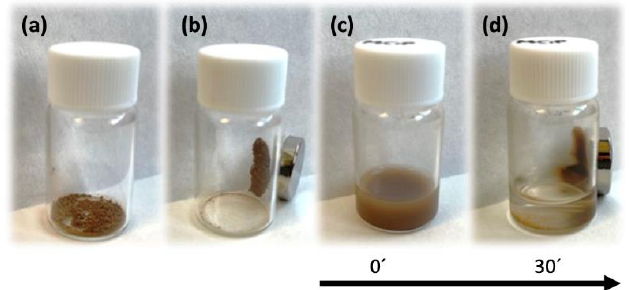
Figure 10. Magnetization test of dry magnetic CIP/ZIF (0.6 mg/mg) with ( a ) and without ( b ) magnet; the same material in water with ( c ) and without ( d ) magnet.